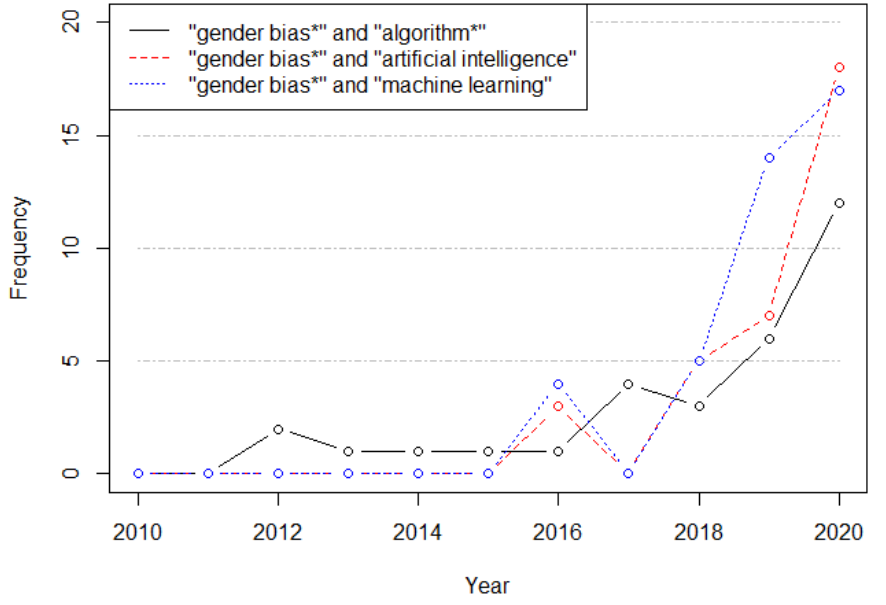
Figure 1. Scopus-indexed articles for different gender-related